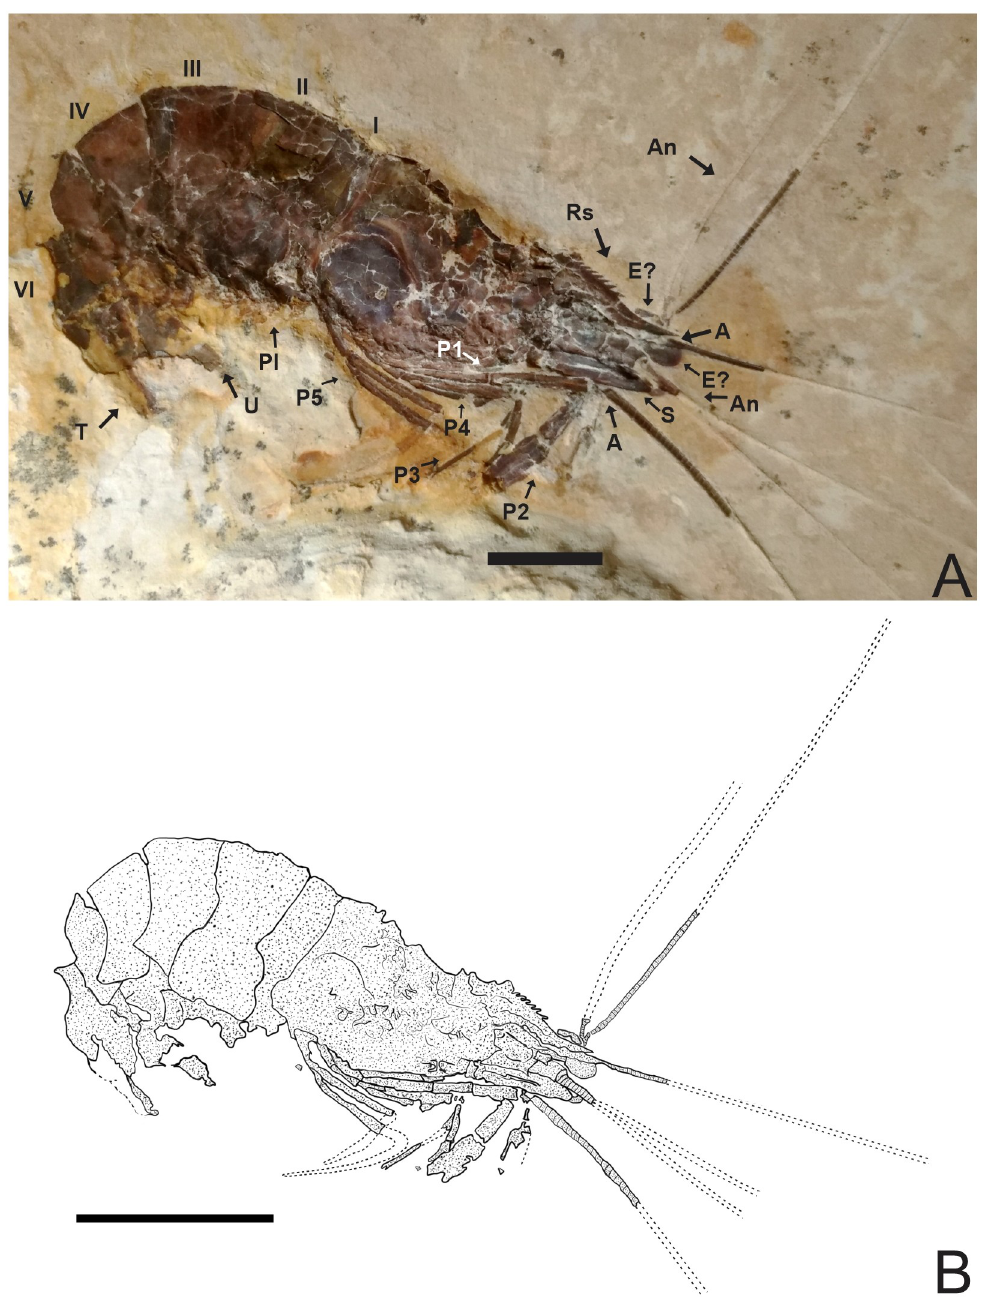
Fig 10. Lateral view of the UFRJ 171/CR. (A) second pereiopod are represented by cheliped. (B) Reconstitution, dotted lines represent appendages not preserved but with impressions on the matrix. Rs: Rostrum; An: Antennule; E: Eyes; A: Antenna; S: Scaphocerite; P1-P5: Pereiopods; Pl: Pleopods; I-VI: Pleon; T: Telson; U: Uropods. Scale bars: 10 mm. Photo and drawing by Olga A. Barros. rostrum partially preserved, with 9 well evident supra-rostral spines and the fragmented end of the rostral tip seems to have 11 rostral spines with serrate appearance; sub-rostral spine not discernible; laminar scaphocerite present; antennal and branchiostegal spines not discernible in carapace; smooth pleon without spines, pleura of second somite strongly rounded,